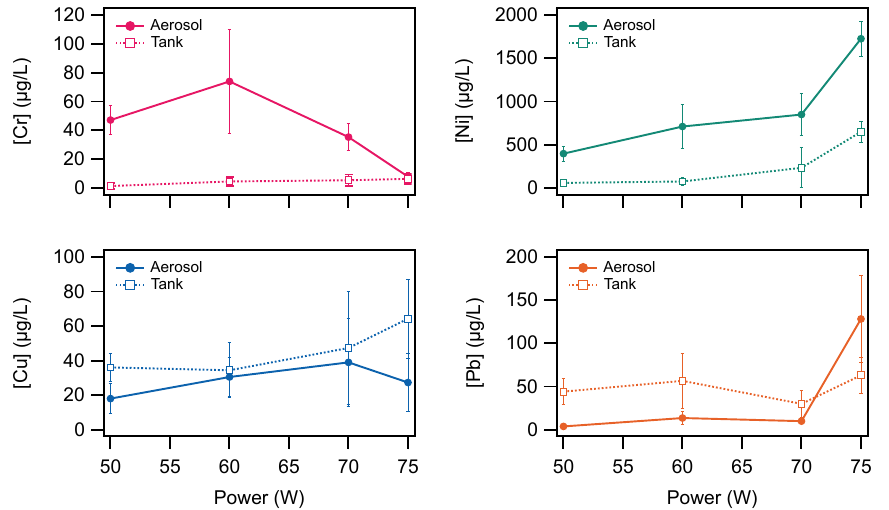
Figure 4. Mean concentration of metals in the aerosol (solid markers) and tank (open markers) from 10 to 40 puffs plotted as a function of power. Note: Error bars are ± the mean standard deviation of each